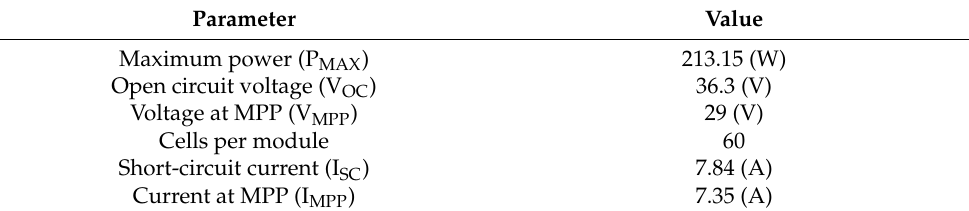
Table 1. SunPower SPR-X20-250-BLK module